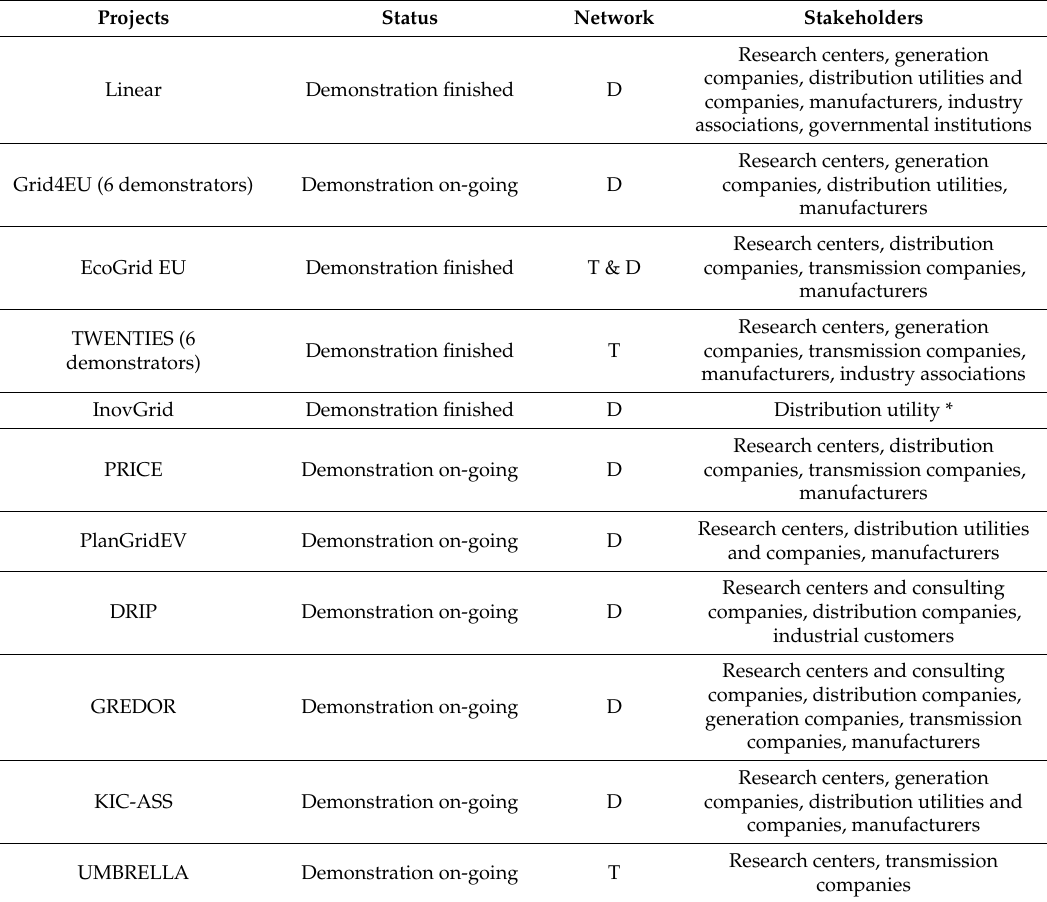
Table 2. Projects that participated in the